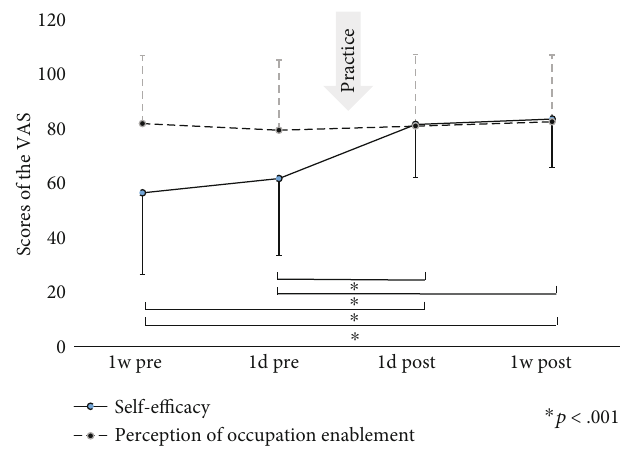
Figure 2: Changes in the visual analogue scale scores on self-e ffi cacy and perceptions of occupation enablement at four periods before and after the practice. 1 w pre: 1-week preintervention; 1d pre: 1-day preintervention; 1d post: 1-day postintervention; 1 w post: 1-week postintervention. Table 1: Strati fi ed areas of distribution on the change amount of visual analogue scale (VAS) scores (unit: number of